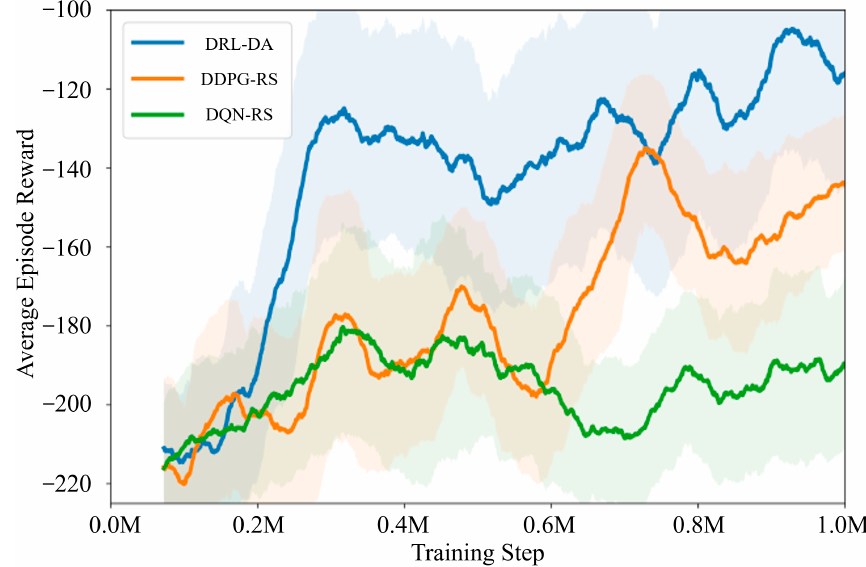
Figure 20. Training process of three different algorithms.